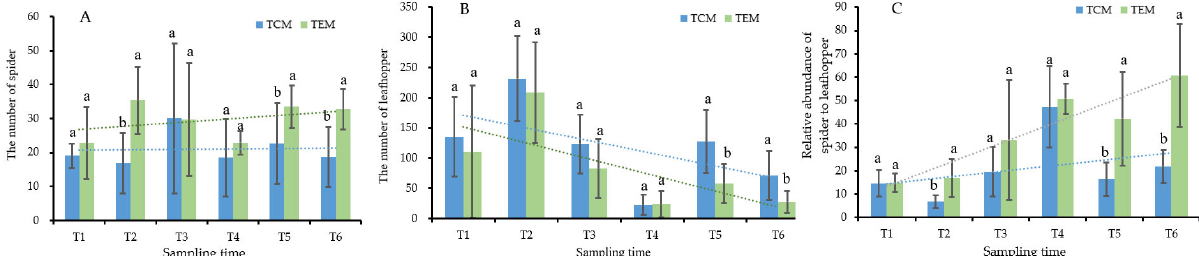
Figure 2. The effects of management mode on the leafhopper pest and its enemy. The different letters labeled in columns are significantly different according to Duncan’s test ( p < 0.05). ( A ) The number of spiders, ( B ) the number of leafhoppers, and ( C ) the relative abundance of spiders to leafhoppers. TCM = tea conventional management; TEM = tea ecological management. T1 = spring 2016; T2 = autumn 2016; T3 = spring 2017; T4 = autumn 2017; T5 = spring 2018; T6 = autumn 2018.